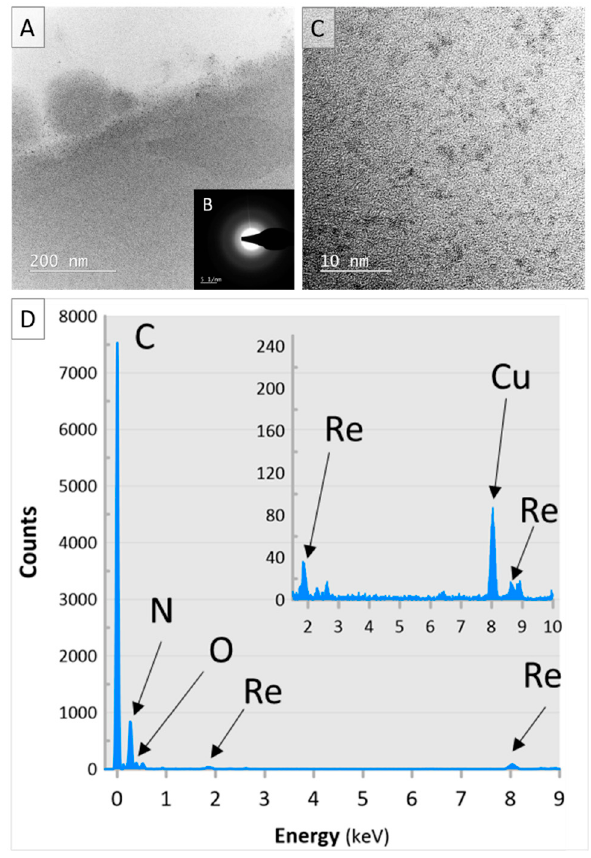
Figure 4. ( A , C ) TEM photomicrographs supplied with ( B ) SAED and ( D ) EDX spectra of the Re@NCat sample. The inset in panel D is a magnification of the EDX spectrum recorded in the range of 2–10 keV.